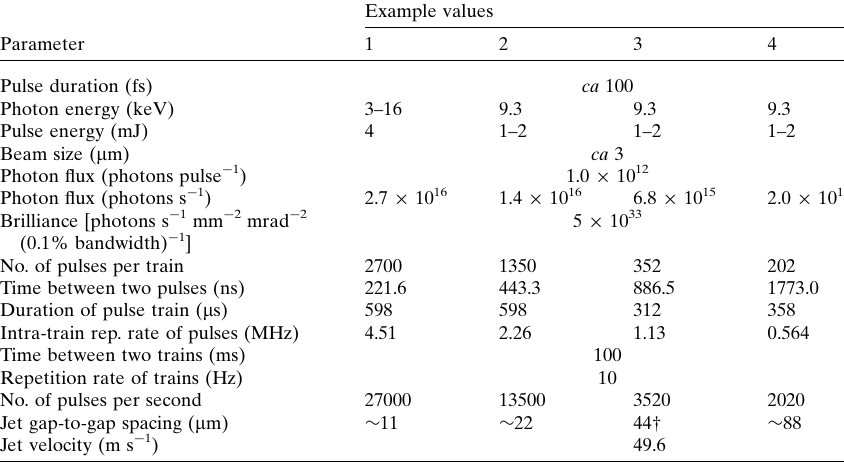
Table 1 Overview of X-ray parameters for various example settings on the SPB/SFX instrument. The pulse energies in settings 2–4 are comparable as the accelerator is usually running at 2.26 MHz and electron bunches are delivered interleaved to SASE1 and SASE3 ( i.e. maximum 1.13 MHz delivered to each of SASE1 and SASE3). The number of X-ray pulses per 10 Hz train can be varied, leading to different intra-train repetition